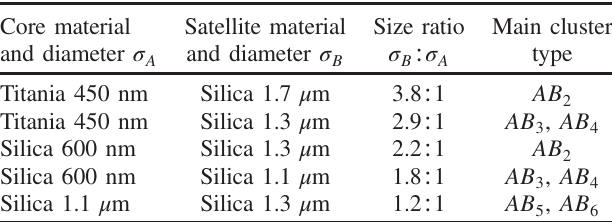
TABLE I. Size of core and satellite particles and resulting cluster types for mixtures of positively charged core particles and negatively charged satellite particles. For the core particles, either titania or silica is used. Satellite particles are always made of silica.